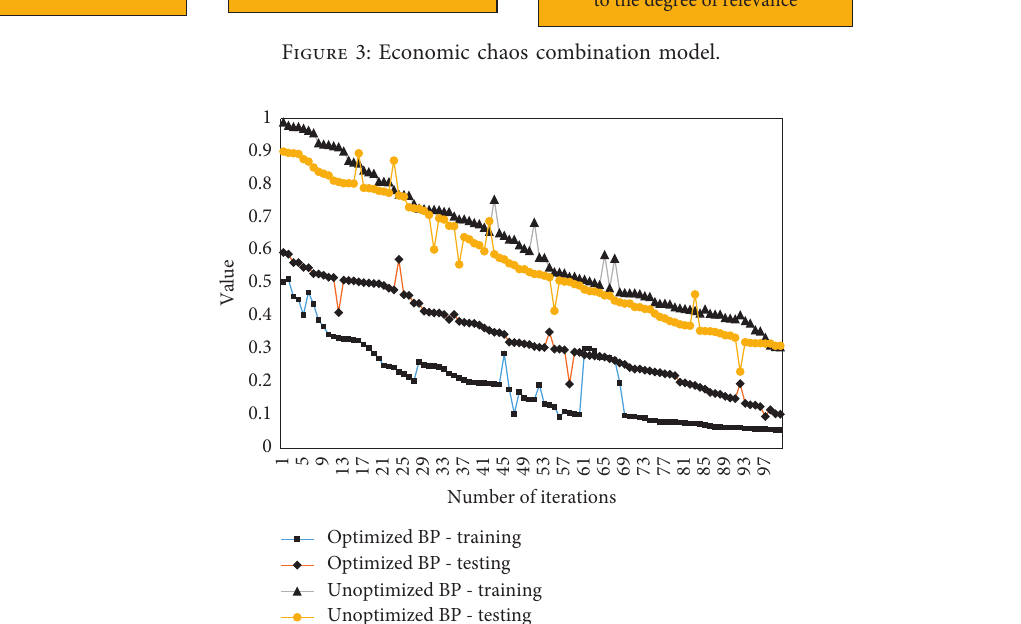
Figure 4: Error curve of BP neural network training and